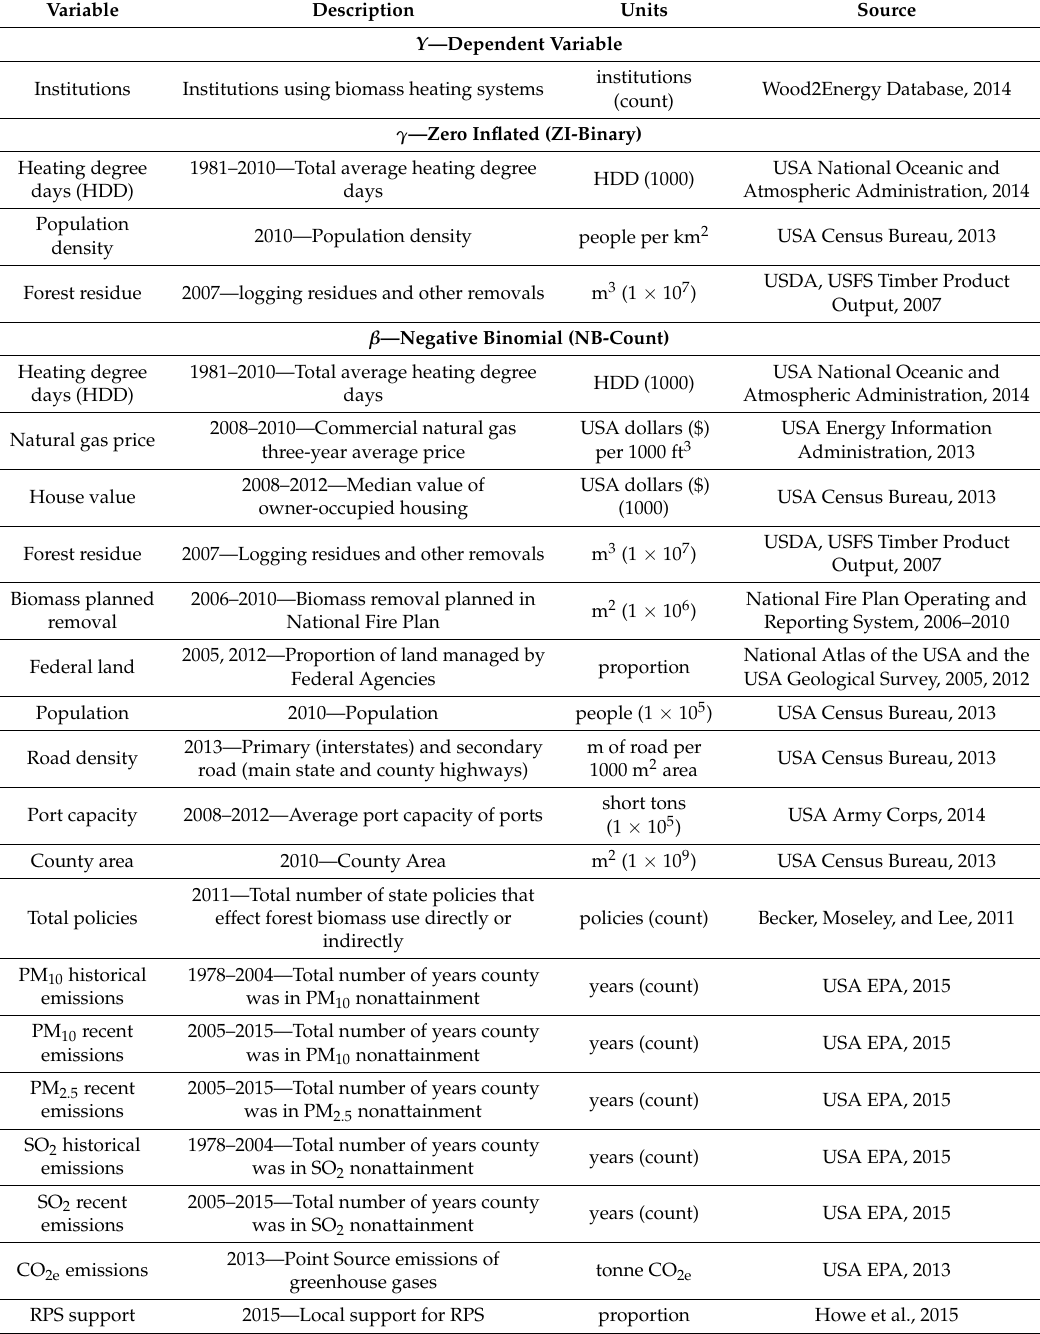
Table 2. Variables used in the zero inflated negative binomial (ZINB) model. Resolution of the data is by county, with 3142 counties in the dataset, except for natural gas price and total policies, which are at the state